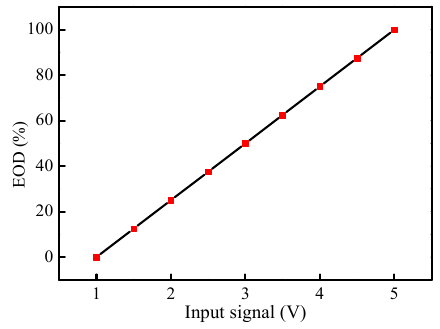
Figure 6. Relationship of input signal and opening.